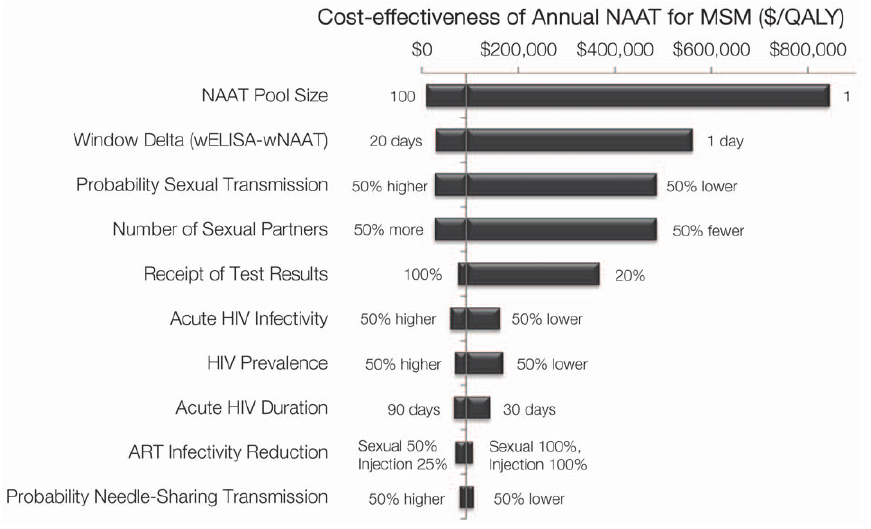
Figure 3. Tornado diagram with variations in model parameters. One-way sensitivity analysis of model parameters, where each horizontal bar shows the range in cost-effectiveness given variations in each parameter value. The vertical line shows the base case cost-effectiveness ( $ 92,000 per QALY gained). Cost-effectiveness of annual NAAT testing of MSM is relative to annual screening with fourth-generation immunoassay only. MSM = men who have sex with men; NAAT = nucleic acid amplification test; QALY = quality-adjusted life year; ART = antiretroviral therapy; window delta = days between NAAT and immunoassay positivity.